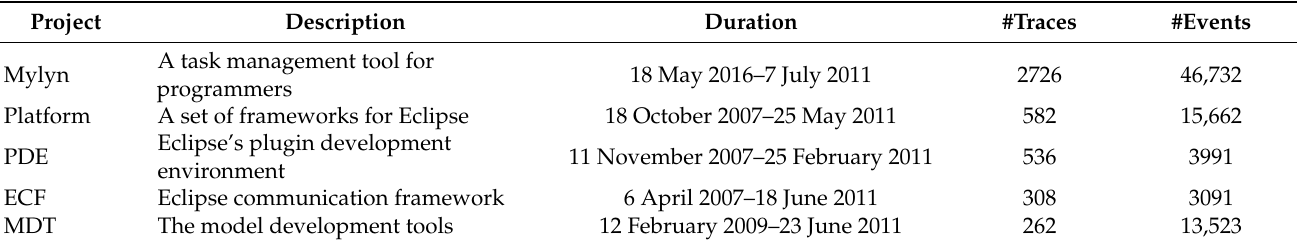
Table 1. Target projects for experiments.